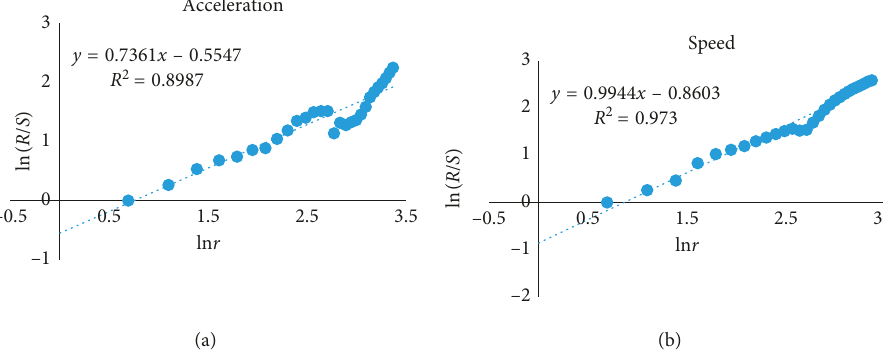
Figure 6: The analysis result of R / S data of NGSIM trajectory data: (a) result of acceleration of R / S and (b) result of speed of R / S